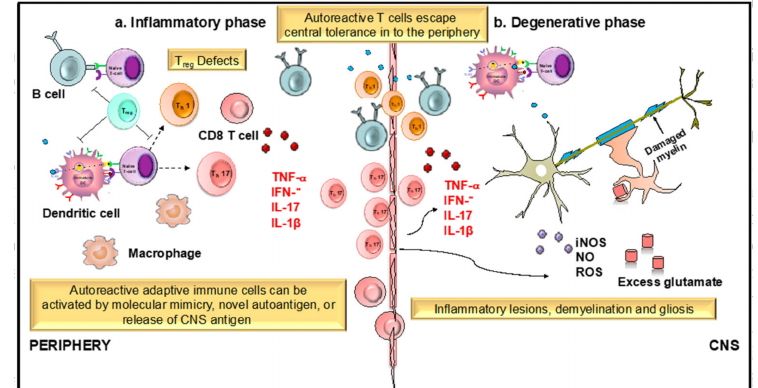
Figure 3. Role of dendritic cells (DCs) and T cells in the development and progression of multiple sclerosis (MS). MS is an immune mediated disease characterized by an initial inflammatory event consisting of presentation of as yet unknown antigens to CD8 T cells, their entry across the blood–brain barrier (BBB) into the central nervous system (CNS), and their subsequent reactivation by CNS resident DCs and microglial cells. This results in an inflammatory cascade involving secretion of several proinflammatory mediators such as cytokines IL-1 β , IL-17, and TNF- α . The release of these cytokines initiates the degenerative phase that is characterized by increase in iNOS, NO, glutamate, and ROS, which brings about formation of inflammatory lesions, gliosis, and demyelination, which are the hallmarks of